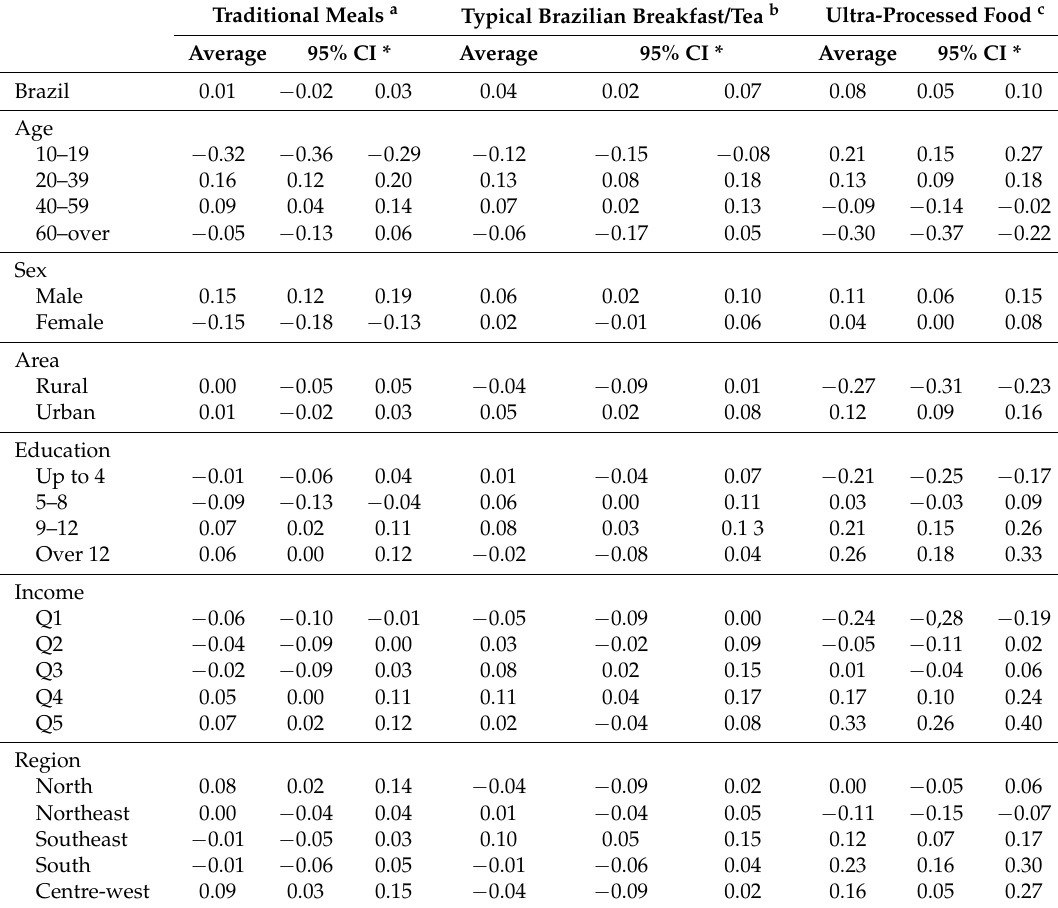
Table 2. The score patterns average for meals eaten outside of the home according to personal, demographic and socioeconomic characteristics. Brazilian population aged 10 and up